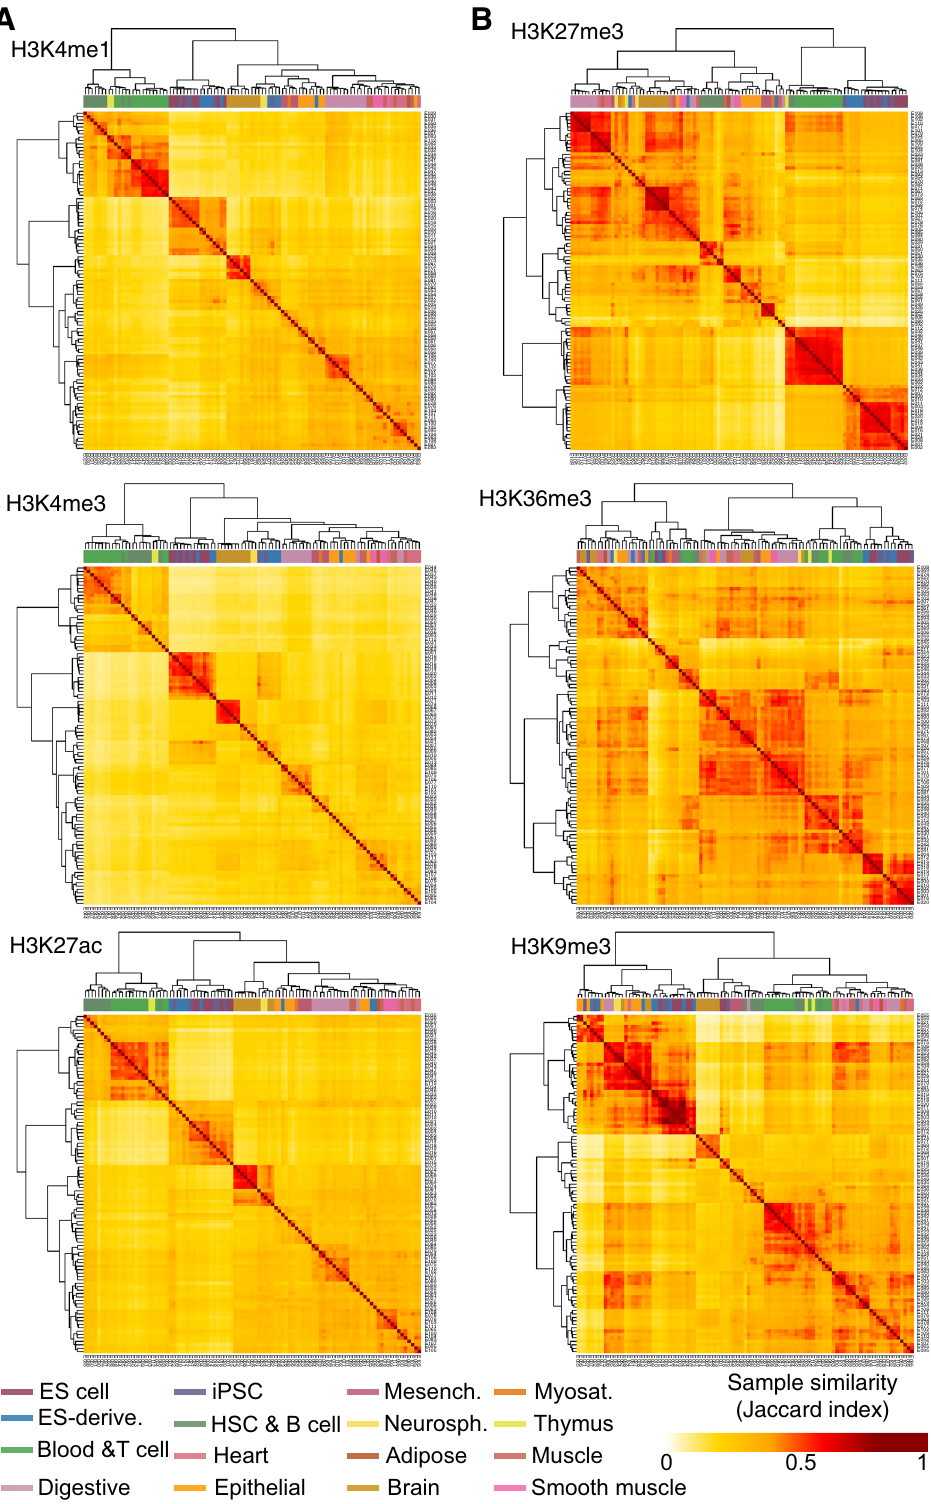
Fig. 2 LOCKs are predictive of cell identity according to tissue of origin. Unsupervised clustering of 13 primitive, 9 ES-derived and 77 differentiated cell types according to the similarity in the genomic localization of LOCKs from A H3K4me1, H3K4me3, H3K27ac and B H3K9me3, H3K27me3, H3K36me3 histone modi fi